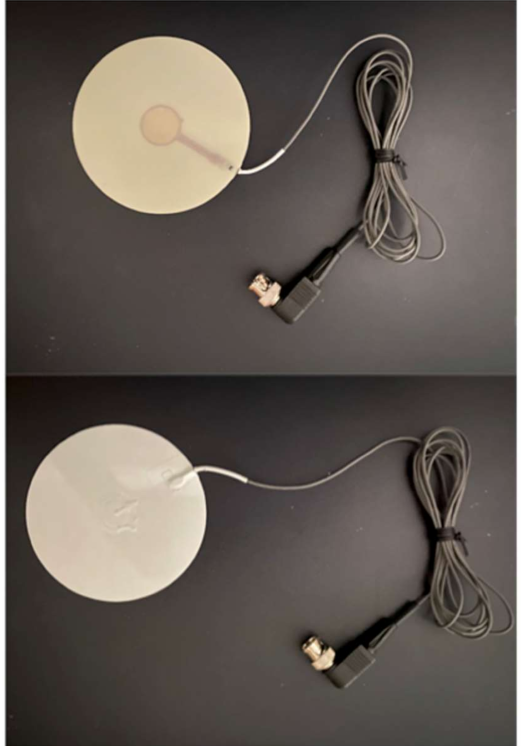
Figure 1. The appearance of the piezoelectric sensor (PS). The upper panel shows the bottom surface of the PS. The lower panel shows its top surface, which faces the patients. The diameter of the sensor is 100 mm. The sensor is covered with an insulation